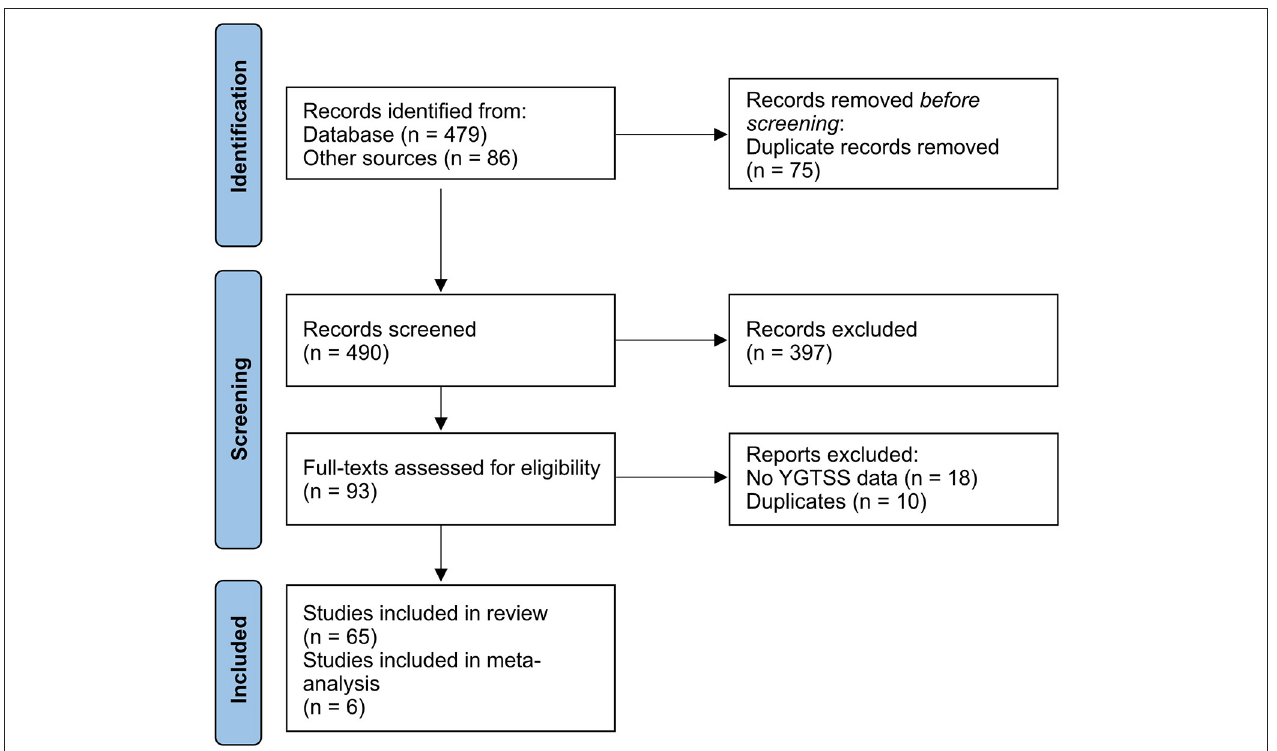
FIGURE 1 | Adapted PRISMA 2020 flow diagram